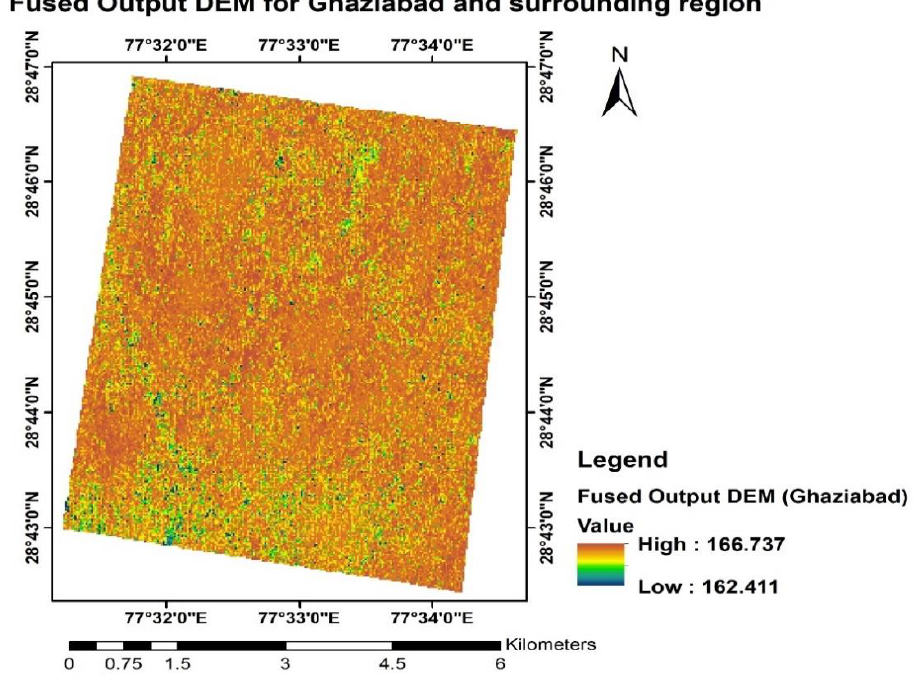
Figure 5. Fused Output DEM obtained from Neural Network based fusion approach for Ghaziabad and surrounding regions. Table 3. Results for ANN fusion approach for Fused DEM assessed with TanDEM-X 90 m DEM in Ghaziabad and surrounding